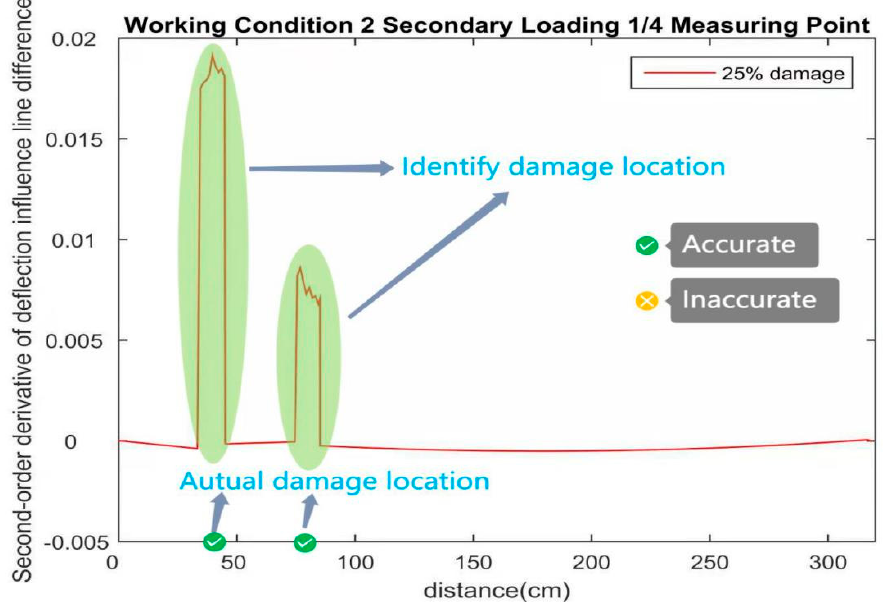
Figure 37. The second-order derivation of deflection influences line difference at 25/100 measuring point of the first span under work condition 5.